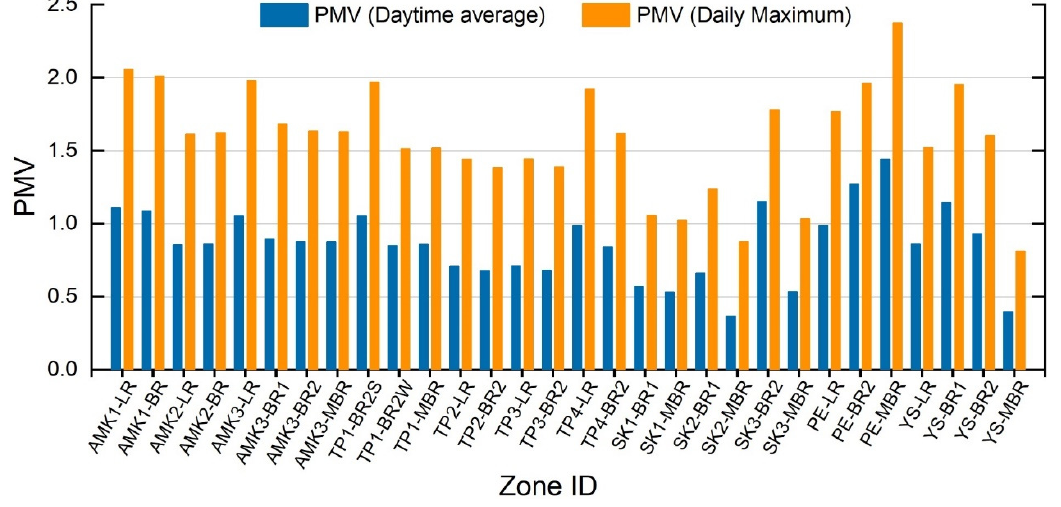
Figure 13. Average and maximum PMVs in target zones for window open scenario.